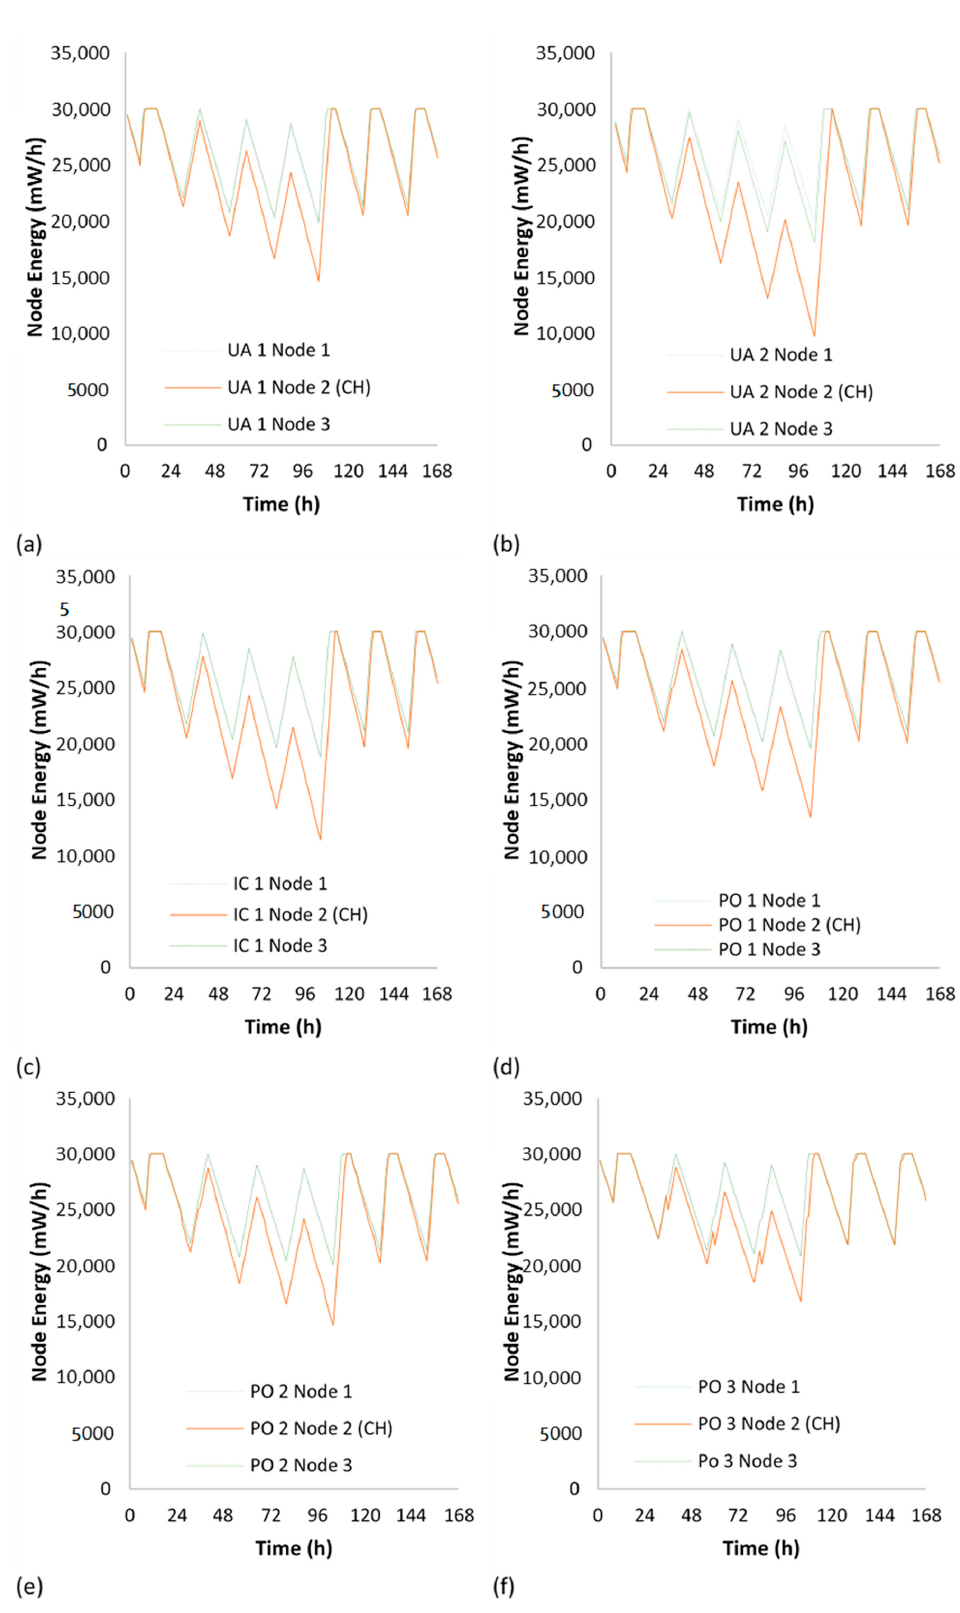
Figure 12. Energy consumed by the nodes. Summary of the whole simulated period. Different